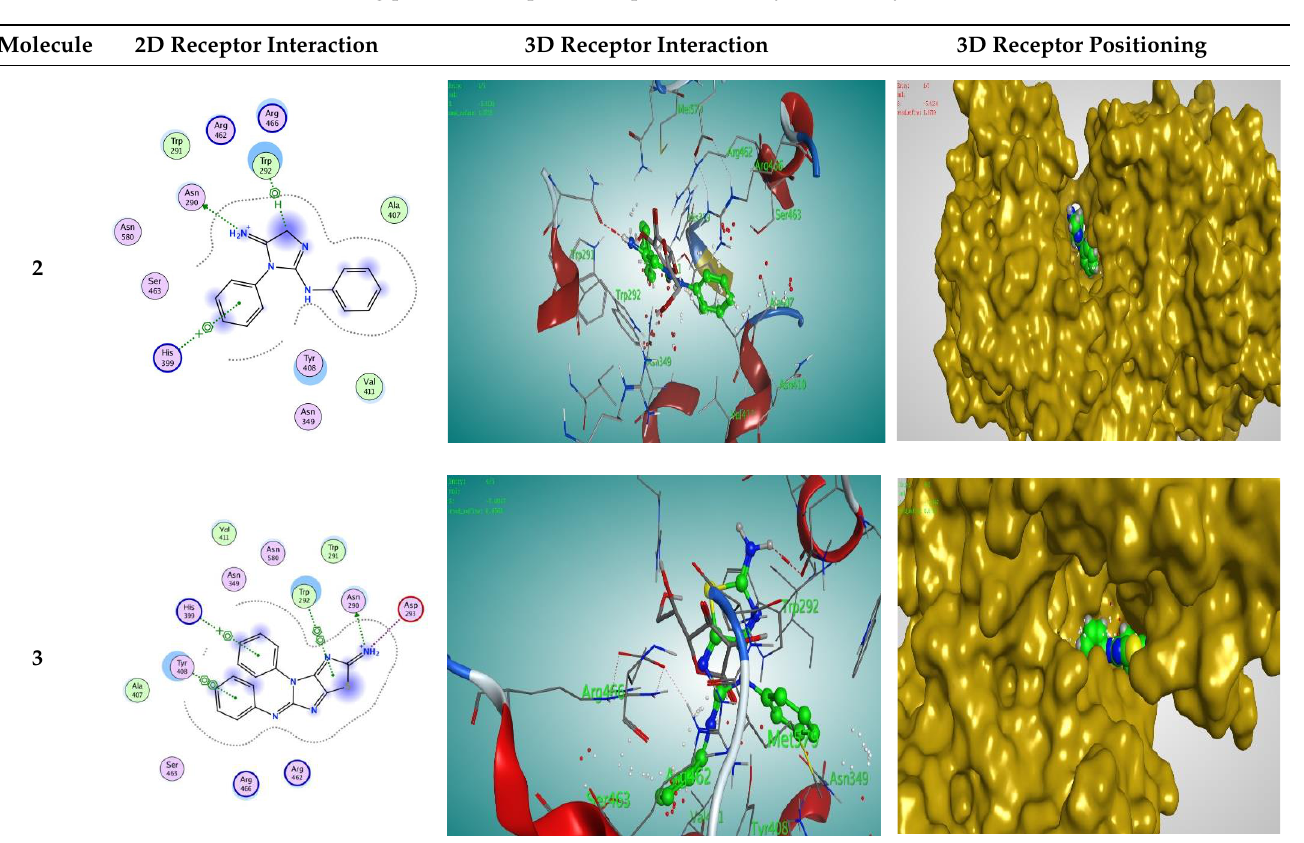
Table 6. 2D and 3D receptor interactions and receptor positioning of the most significant potential candidates ( 2 , 3 , 5 , and 6 ) compared to the docked ascorbic acid as a reference standard inside the